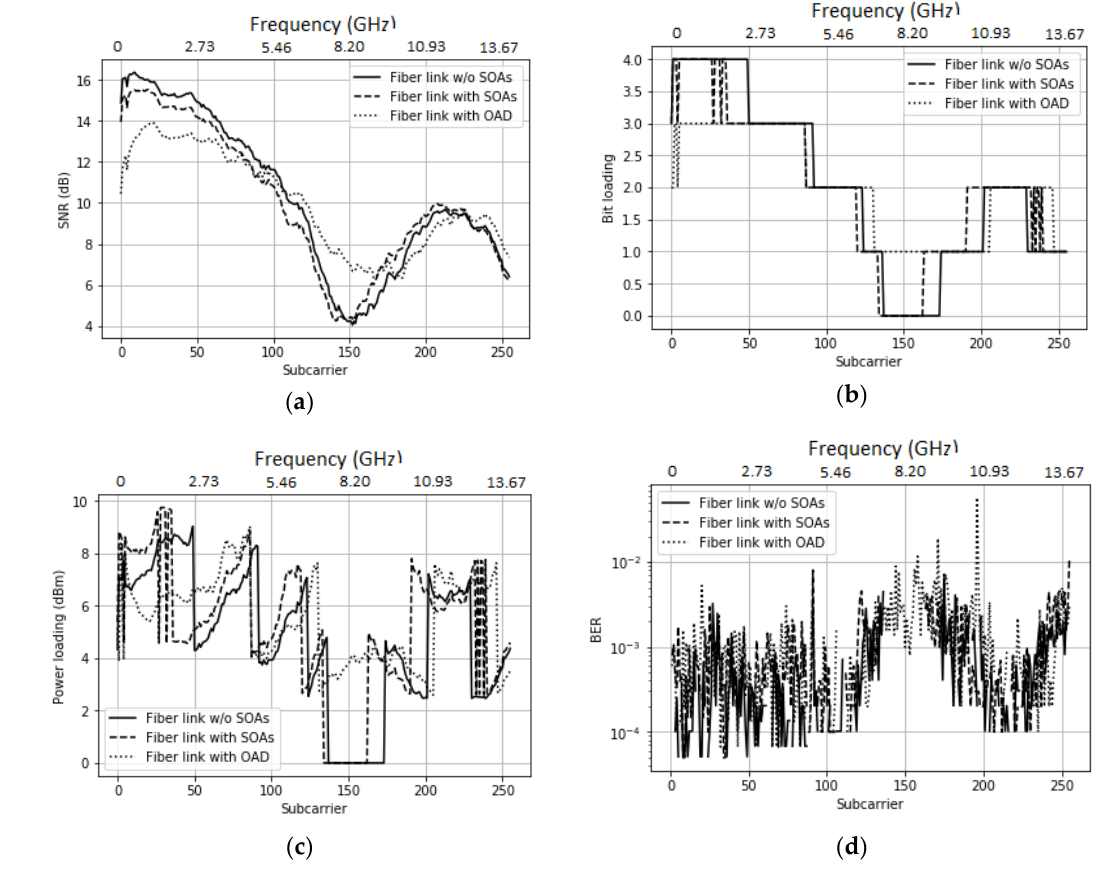
Figure 5. ( a ) SNR profile, ( b ) BL assignment, ( c ) PL assignment and ( d ) BER per DMT subcarrier considering MA transmission at 28 Gb/s over two SSMF spans of 25 km, with and without SOAs and for SOA-based OAD, at 34 dB of OSNR.